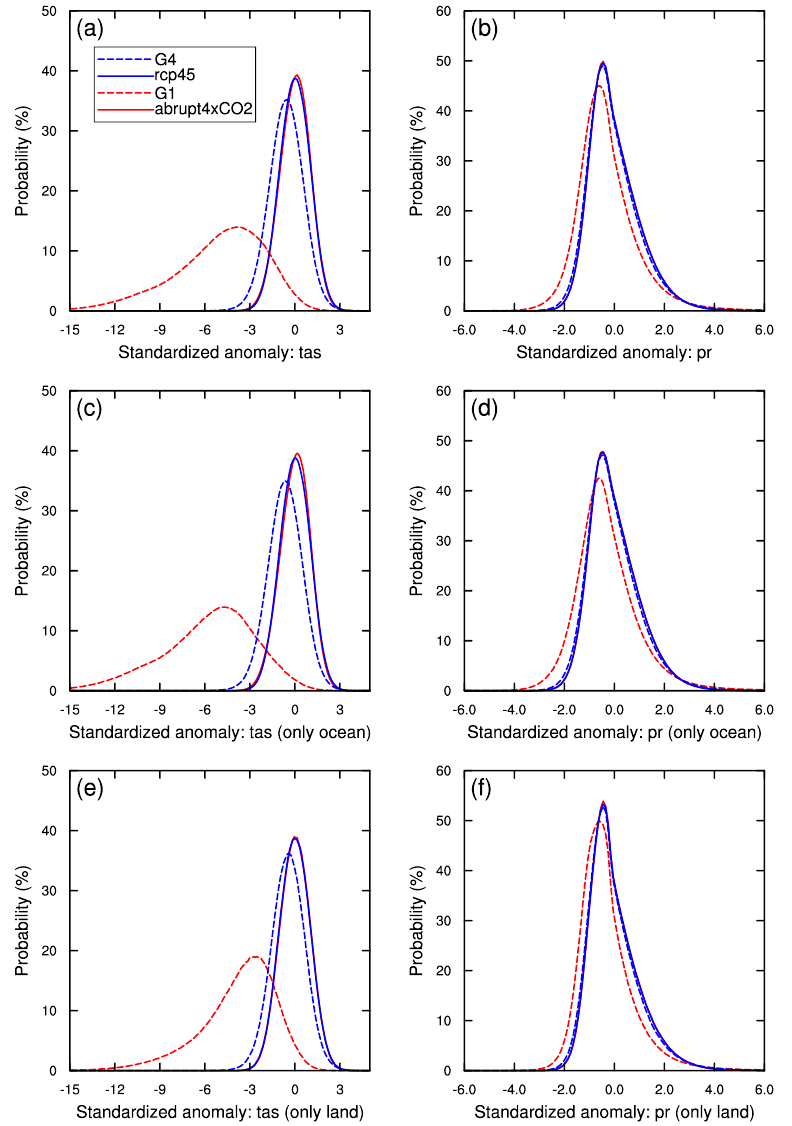
Figure 2. Probability density distributions, normalized to 100%, of standardized monthly mean anomalies for the model ensemble average for four experiments: abrupt4 × CO2 (solid red line), G1 (dashed red line), rcp45 (solid blue line) and G4 (dashed blue line). The PDFs of surface air temperature are shown in panels (a) , (c) and (e) and precipitation in (b) , (d) and (f) . Panel (a) and (b) show global results, panels (c) and (d) ocean-only, and panels (e) and (f) land-only. Tas denotes surface air temperature, while pr denotes